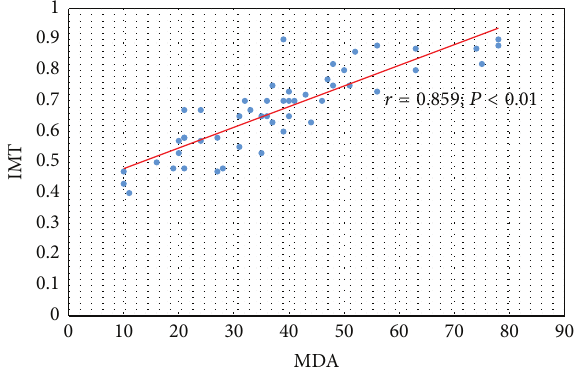
Figure 3: The relation between serum concentration of MDA and IMT-CA in CKD and PD patients.